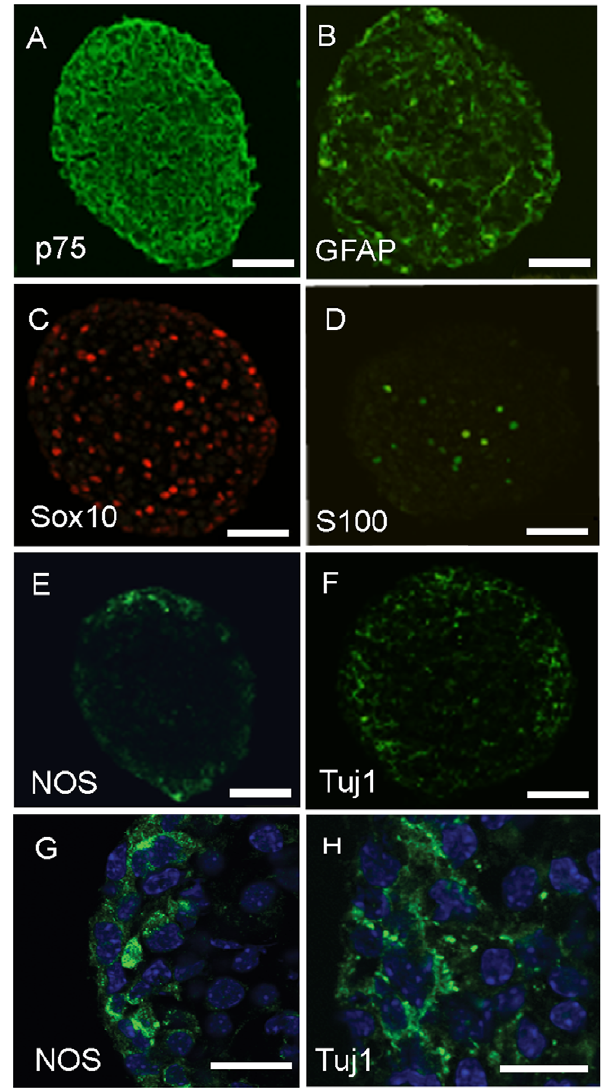
Figure 3. Expression of progenitor, glial and neuronal markers by mouse neurosphere cells. Primary neurospheres were fixed after 15 days culture and 8 m m equatorial sections produced. Confocal immunofluorescence images are shown. G and H are higher magnifi- cations of the peripheral immunofluorescence for NOS and Tuj1 shown in E and F, respectively. Note that NOS and TuJ1 immunofluorescence is located both in cell bodies and fibers (G,H, arrow heads). Scale bars: A– F: 25 m m; G,H: 10 m m.